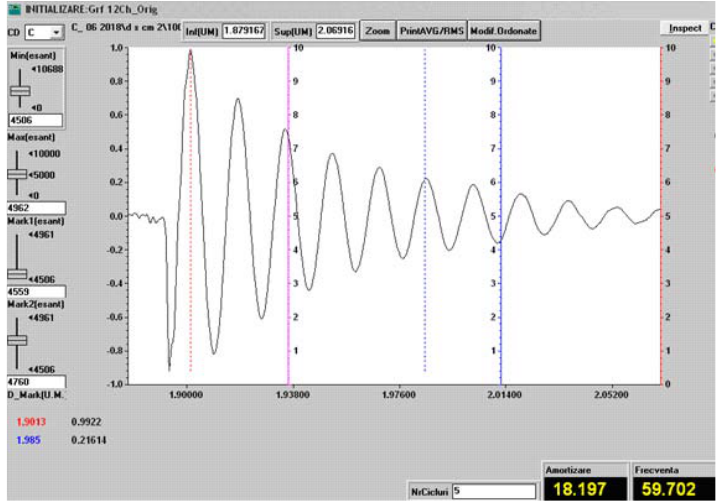
Figure 9. Vibration recording (the characteristic frequency and damping factor) in a sample of the Da 2.x set, for the free length of 120 mm.